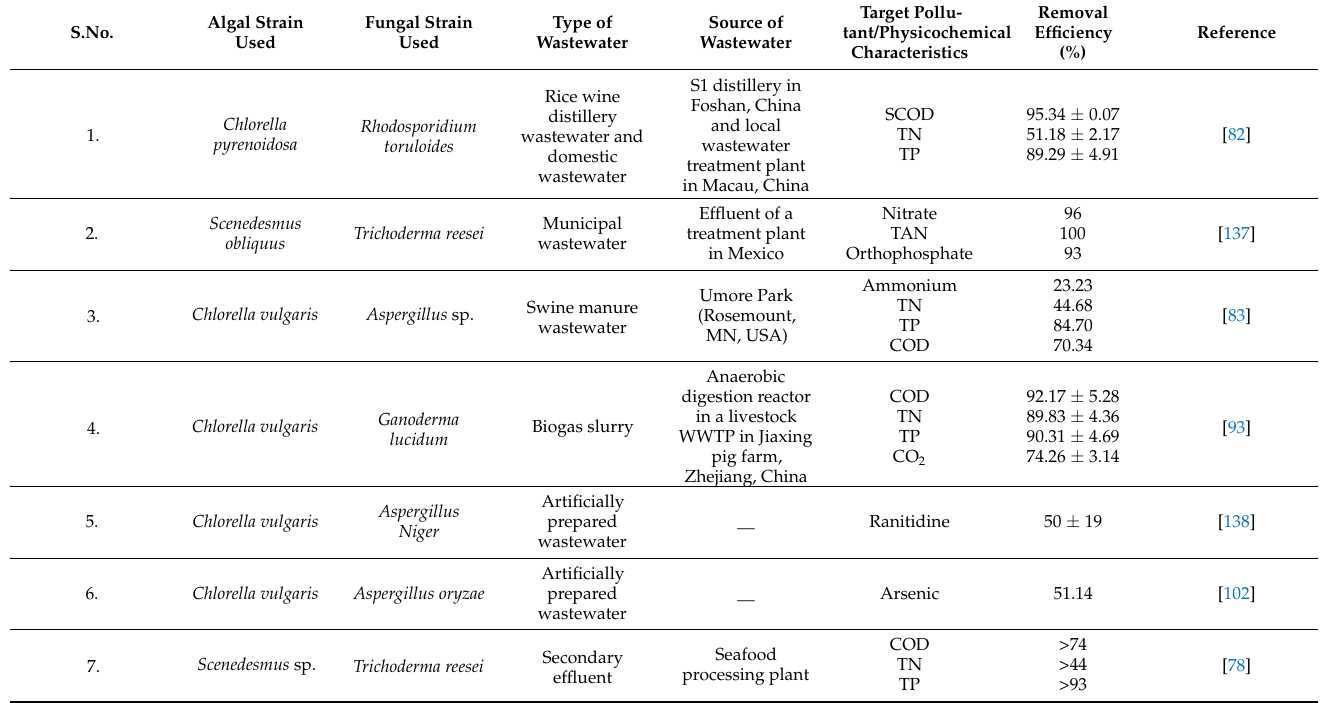
Table 3. Utilization of microalgae–fungi consortium for wastewater